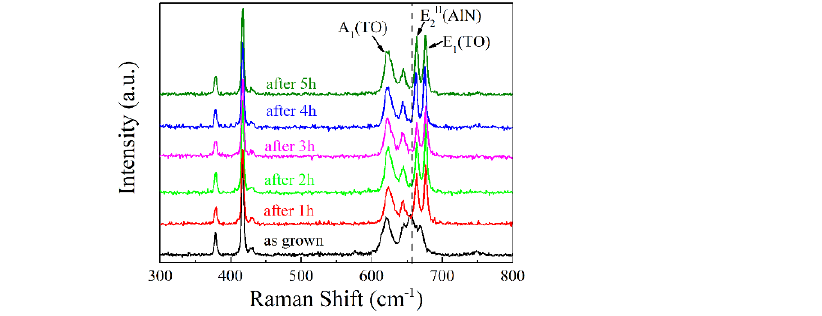
Figure 7. The Raman spectra of 1000 nm-thick AlN samples annealed under different durations.